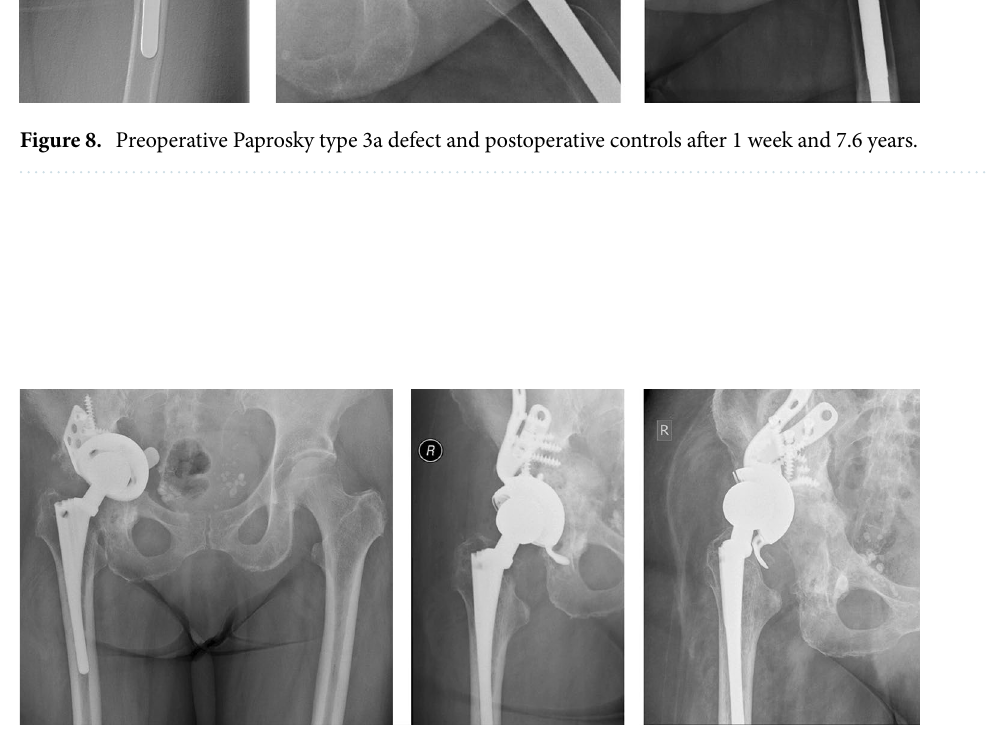
Figure 9. Preoperative Paprosky type 3a defect and postoperative controls after 1 week and 1.5 years with renewed cup